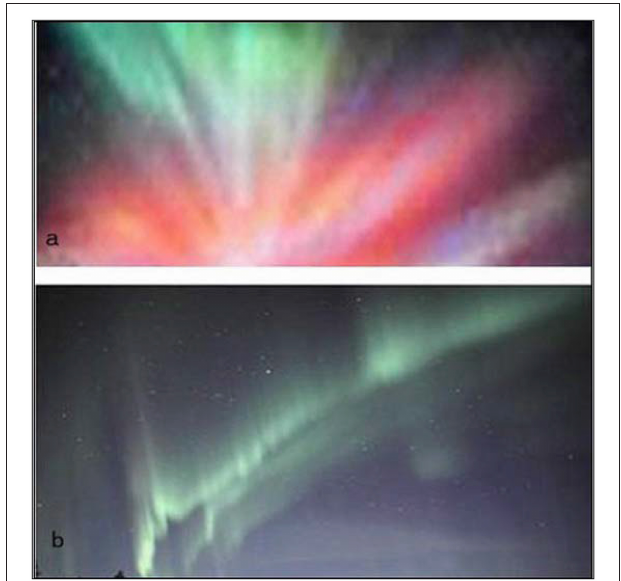
FIGURE 1 | Examples of auroral displays: (a) Corona and (b) rayed arcs (https://en.wikipedia.org/wiki/Aurora).